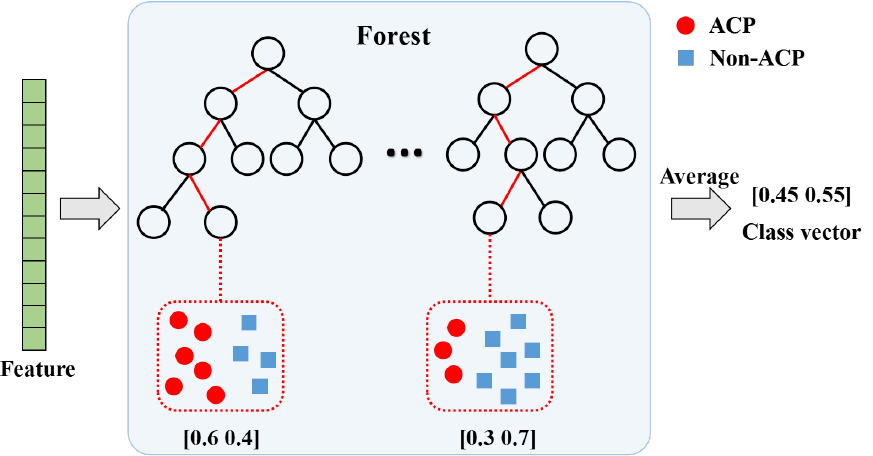
Figure 6. The flowchart for generation of category vectors. Different markers on the leaf nodes indicate various categories. The prediction of ACP is a binary classification mission; therefore, there are two types of markers on the leaf nodes, where red and blue dots represent ACPs and non-ACPs,